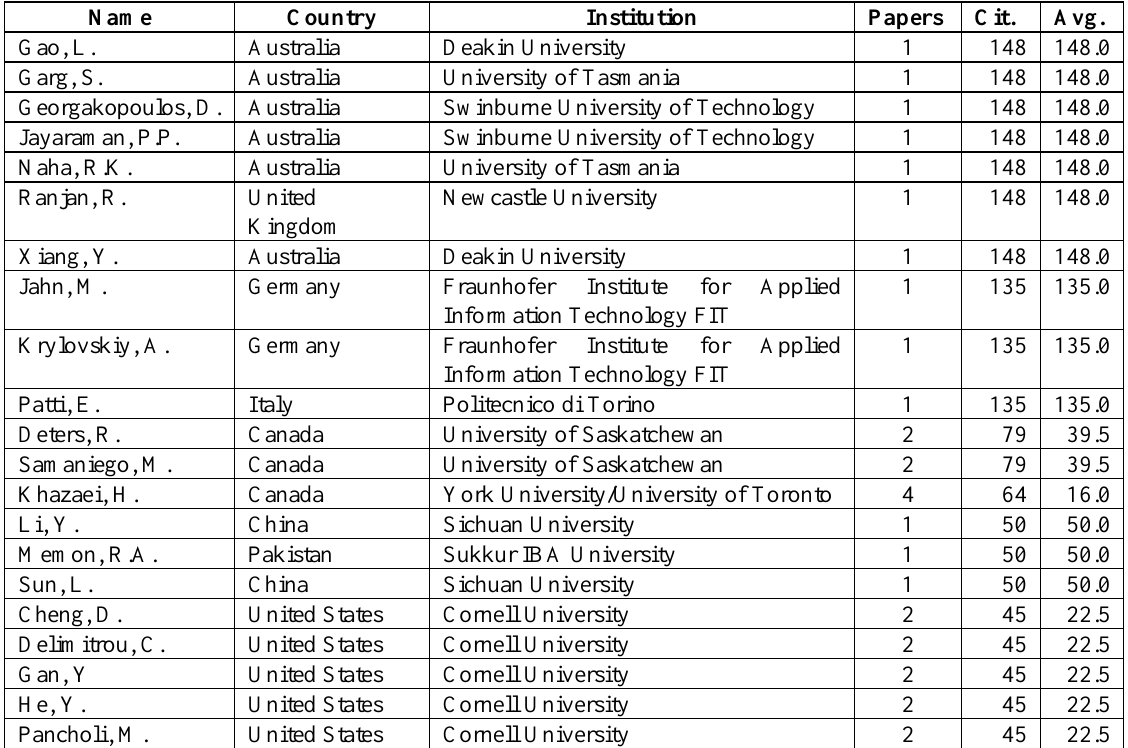
Table 13. List of the top 21 most cited